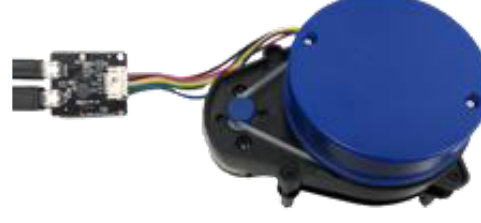
Figure 17. LiDAR (YDLiDAR X4).